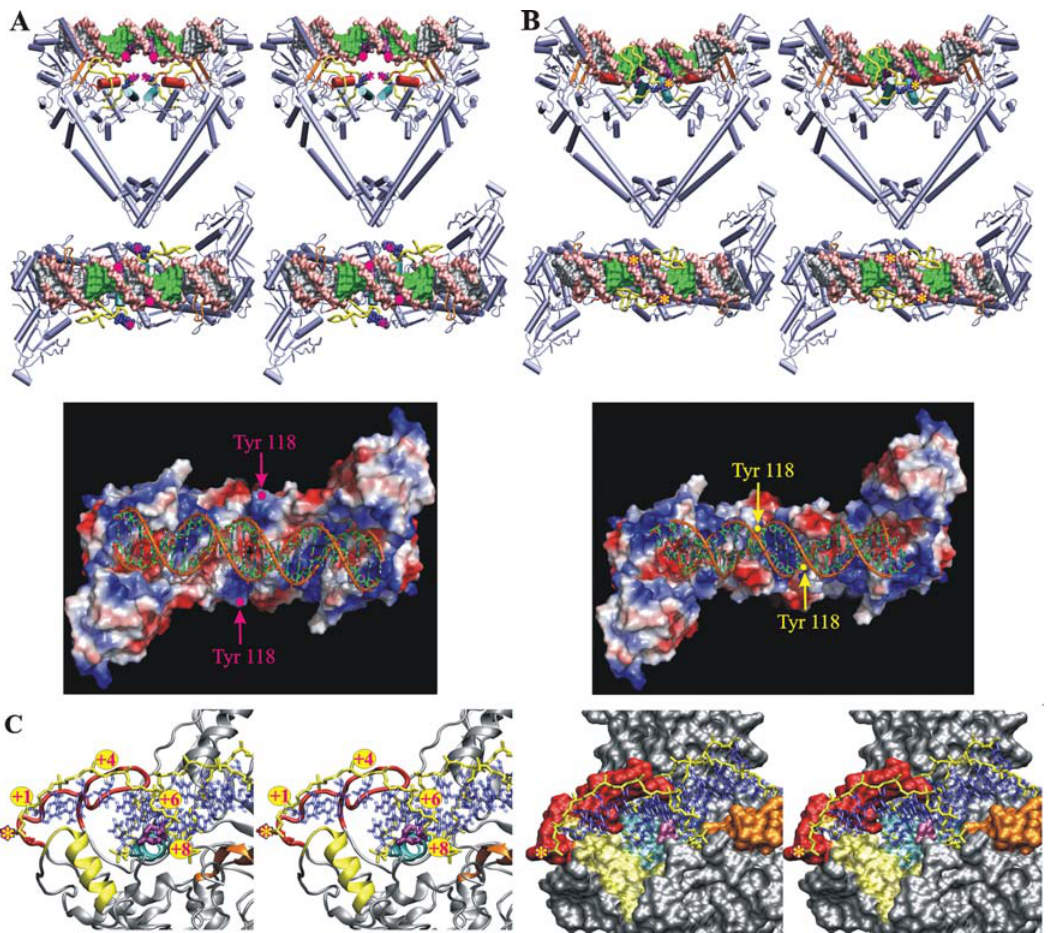
Figure 5. DNA binding, recognition and cleavage by S. pneumoniae ParC. Initial (A) and final (B) stages of DNA binding and recognition are modeled and shown as orthogonal stereo representations of the protein-DNA complex (top) together with the electrostatic surface potential of the DNA binding groove (bottom). The ParC dimer is shown in cartoon mode; the helix a 4 is in red, the helix a 3 in cyan, the 100-122 loop in yellow and Gly 166 - Pro 179 domain in orange. The active-site tyrosines are shown in blue color using CPK mode and indicated by asterisks (magenta for unbound and yellow for bound to the DNA states). The target 5 9 -end phosphates of the DNA molecule are indicated by circles in magenta. The DNA molecule is represented as a molecular surface model; the backbone is in pink, the cleavage points in purple, the base pairs involved in sequence specific recognition in green and non-specific base pairs in silver. (C) Stereo view of the active site of the modelled protein-DNA complex of S. pneumoniae ParC after cleavage and separation of the DNA fragments in cartoon (left) and surface (right) representation. Topo IV cleaves DNA with a 4-base stagger and the active site tyrosines are covalently attached to the 5 9 -ends of the DNA. Ser 79 and Asp 83 which upon mutation lead to quinolone resistance in bacteria are shown in purple, the helix a 4 is in cyan, the helix a 3 in yellow, the 100-122 loop with active site tyrosine in red and Gly 166- Pro 179 domain in orange. DNA molecule backbone is shown in yellow and side chains are in blue. The position of the covalent bond between the active-site tyrosine and the target 5 9 -end DNA backbone phosphate is indicated by a yellow asterisk in a magenta circle. Panels were rendered using VMD [50], Pov-Ray and PyMOL [53].